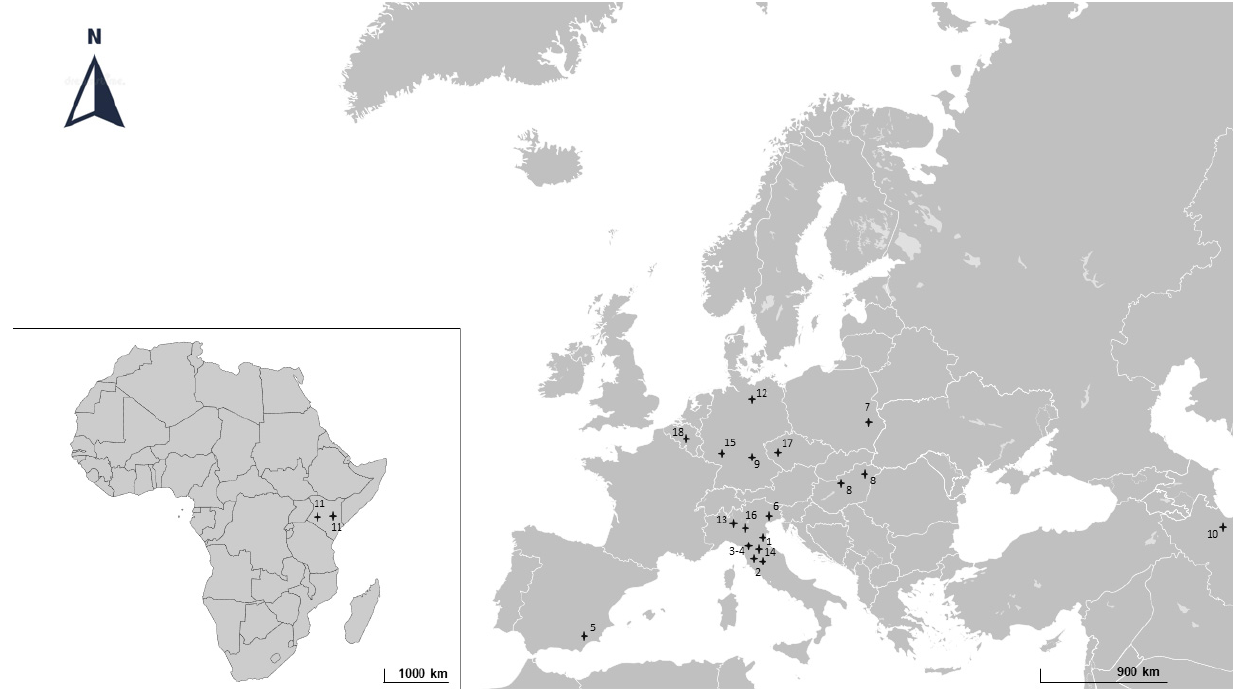
Figure 1. The locations of experiments in Europe, Africa, and the Middle East currently included in LTEP-BIOCHAR. Numbers correspond to the experiments listed in Table 3.